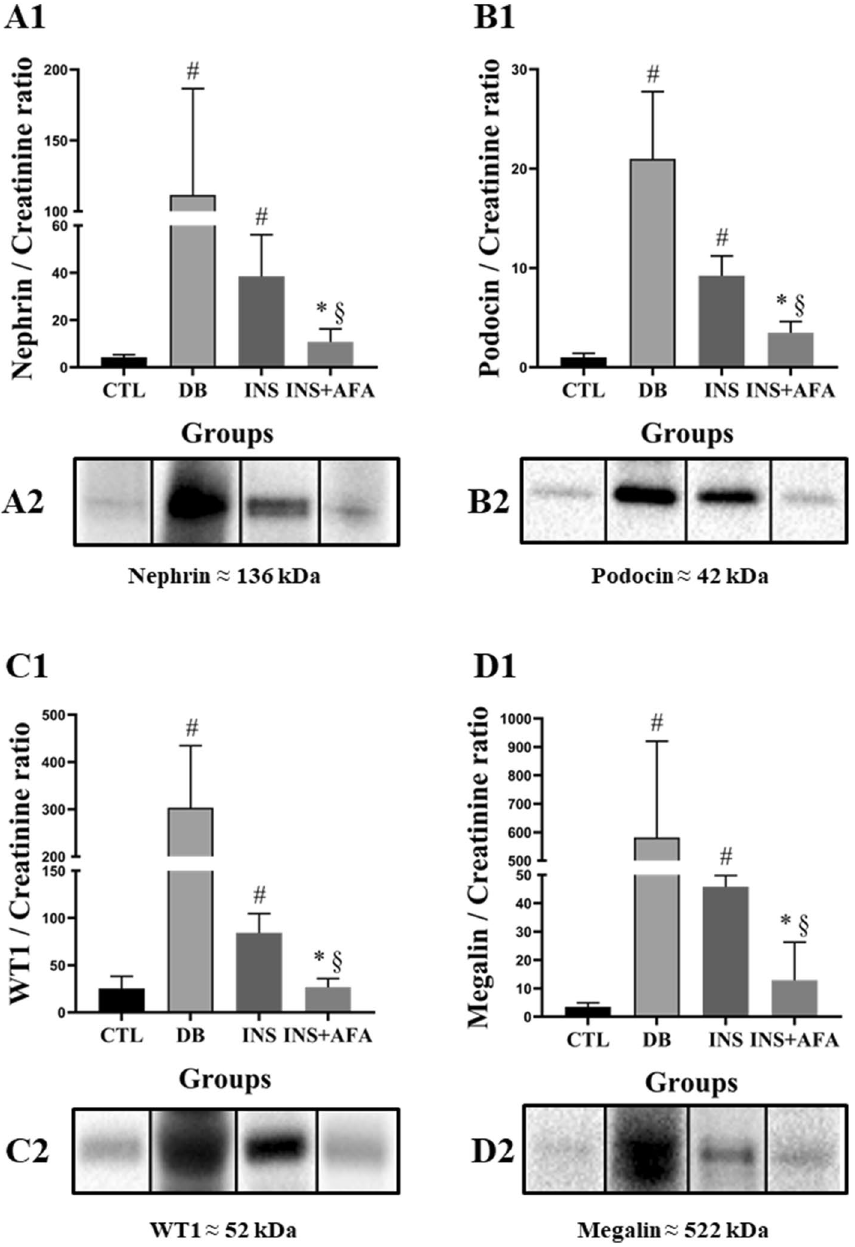
Figure 3. Quantification of urinary protein expression. Protein densitometric analysis ( A1 , B1 , C1 , D1 ); Representative section of western blotting analysis ( A2 , B2 , C2 , D2 ). All bands were cropped and full-length blots are shown in Supplementary Figs. 21–29, respectively. Data were normalized to GAPDH and then corrected to urinary creatinine of each animal; CTL, control (n = 11); DB, diabetic (n = 6); INS, insulin (n = 11); INS + AFA, insulin + aqueous extract of P. edulis (n = 9); # P < 0.05 vs. control group; *P < 0.05 vs. diabetic group; § P < 0.05 vs. insulin